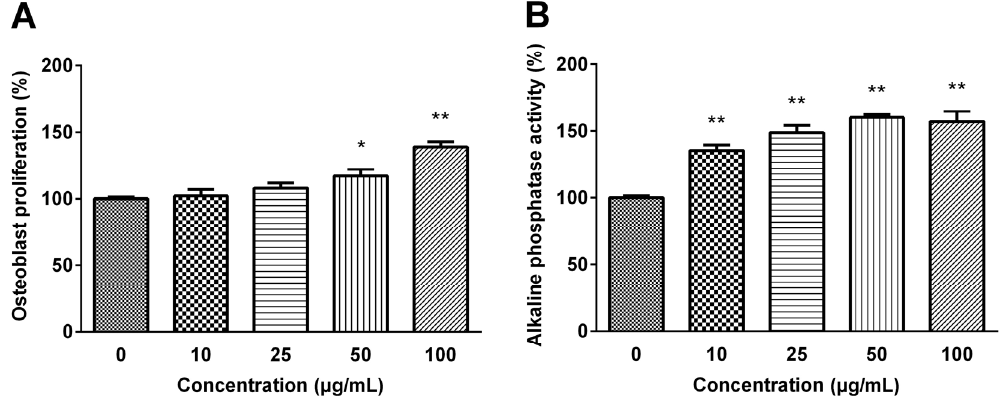
MC3T3-E1 pre-osteoblastic cell alkaline phosphatase activity. The data are expressed as a percentage of the control value, means ± SEM of the three cultures. * p < 0.05 vs. control. ** p < 0.01 vs.